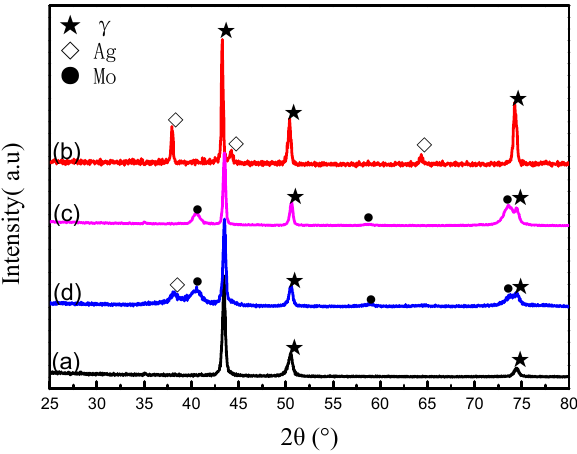
Figure 2. XRD spectra of ( a ) the un-implanted alloy (N); ( b ) silver (A); ( c ) molybdenum (M); and ( d ) silver and molybdenum (AM) before the wear test.